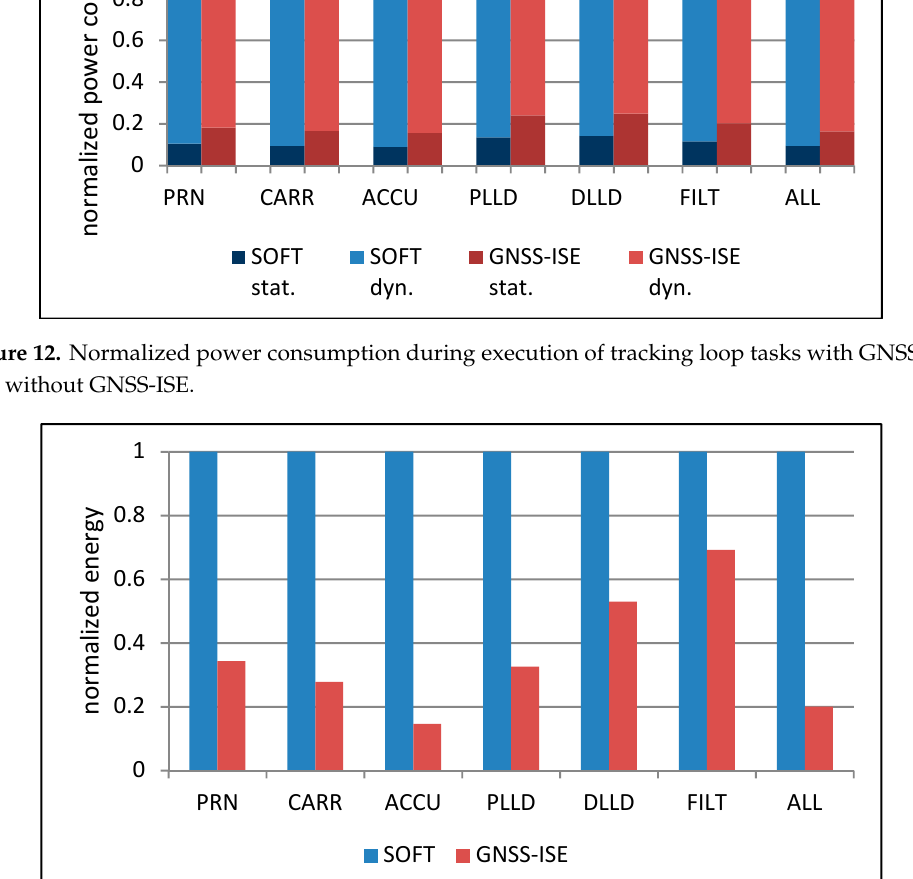
Figure 13. Normalized energy consumption during execution of tracking loop tasks with GNSS-ISE and without GNSS-ISE.